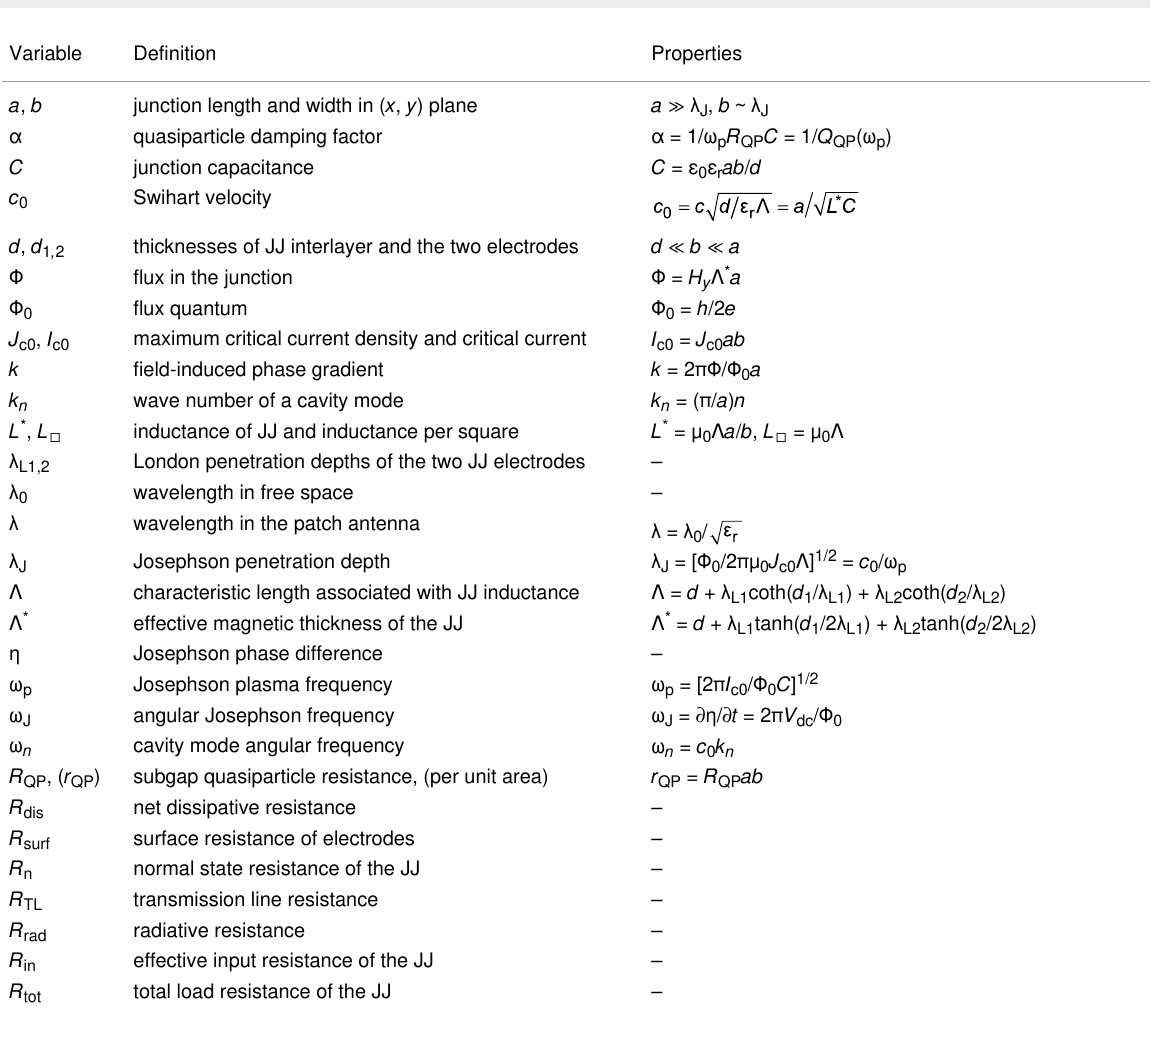
Table 2: Definition of